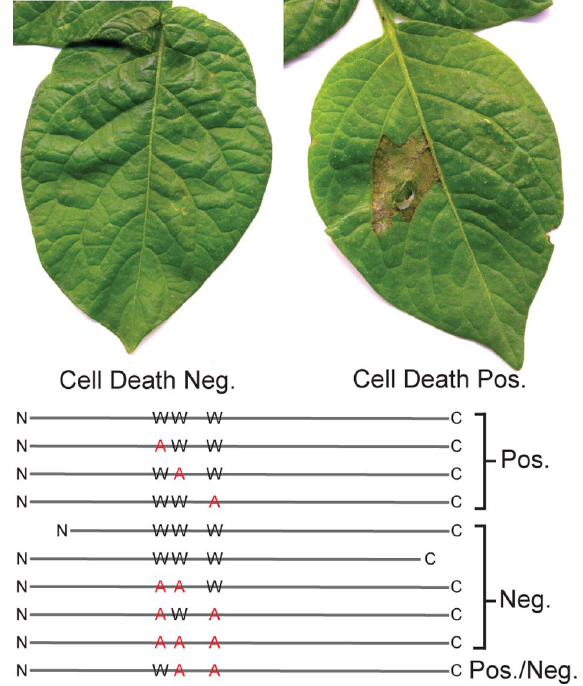
Figure 4. Heterologously expressed DspE causes cell death. Deletion of either the N- or C- terminus as well as certain tryptophan-to- alanine substitutions inhibit function. Agrobacterium mediated trans- formation of S. tuberosum leaves for expression of DspE and a series of mutant constructs. These leaf images are typical of a positive or negative cell death response. Combination of any two of the W to A substitutions reduced or eliminated function. The derivative containing only the two most downstream substitutions caused an inconsistent cell death response.